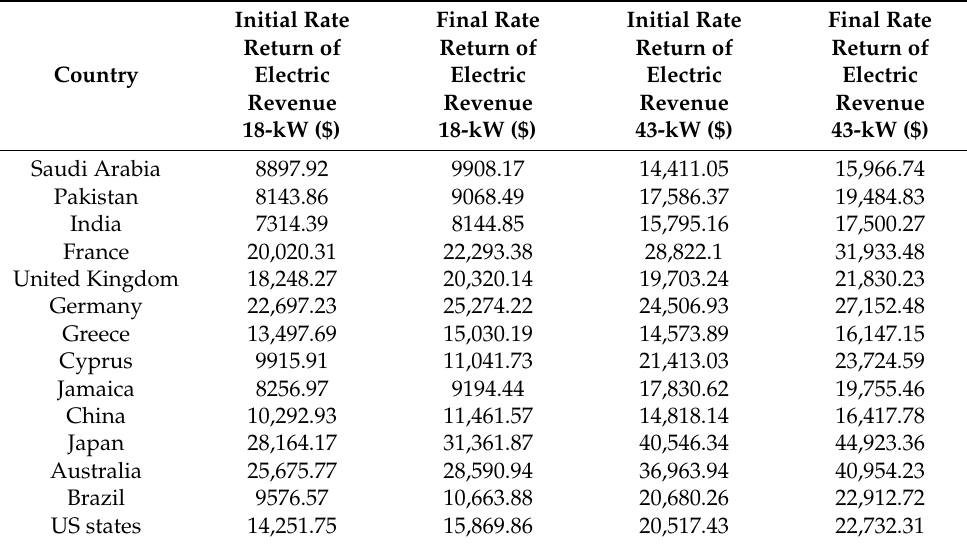
Table 11. The original and final rate returns associated with the 18-kW and 43-kW 10 × 10 PV arrays, without taking into account the greatest economic advantage per